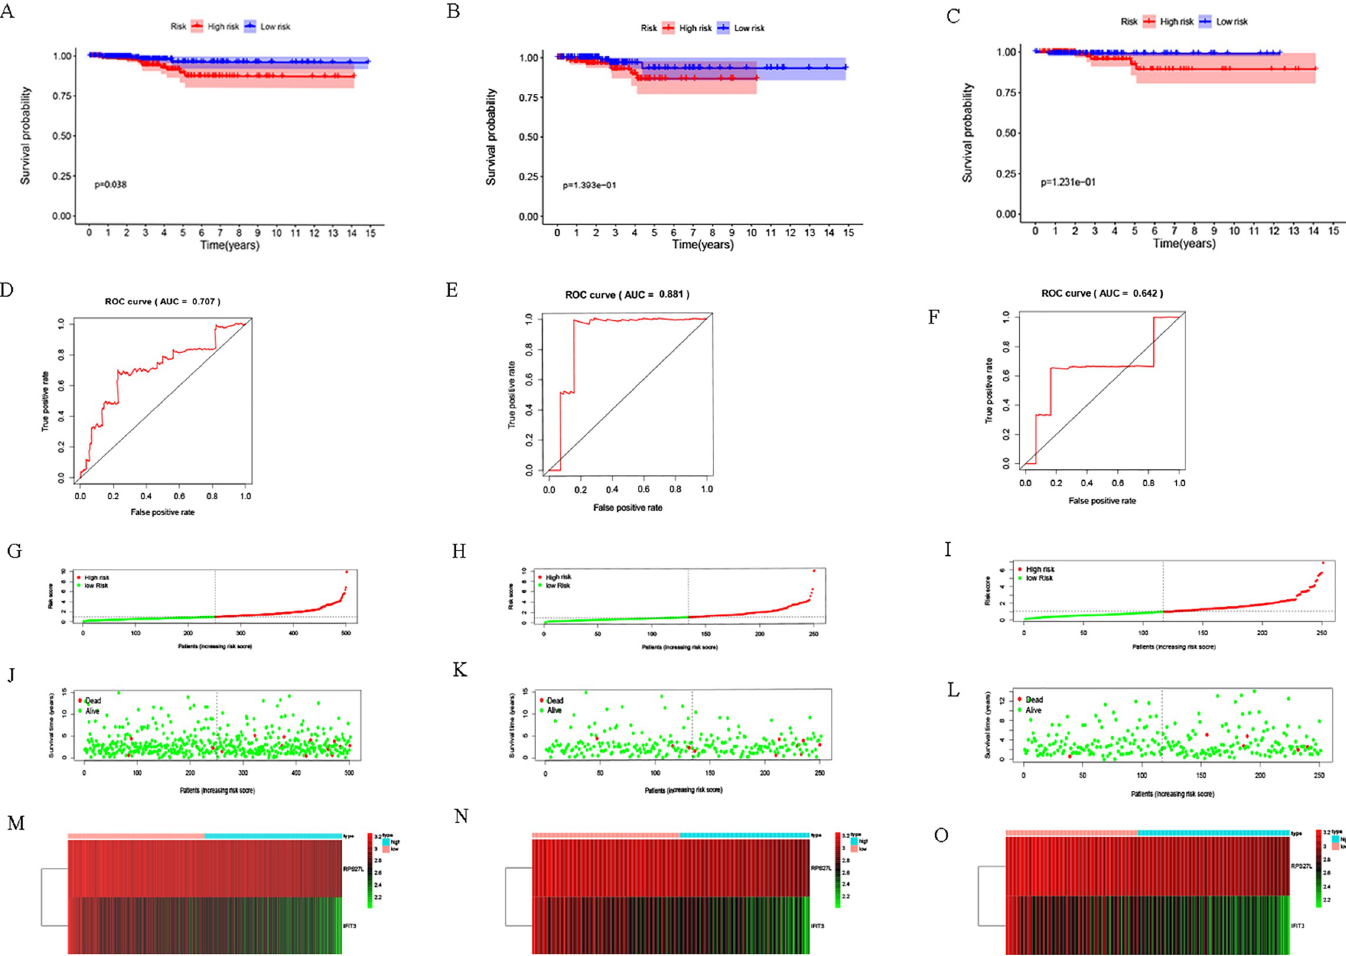
Fig 4. Risk score analysis of the prognostic model. (A) The Kaplan–Meier survival curves in the training set; (B-C) The Kaplan–Meier survival curves in two validation sets; (D) ROC analysis in the training set; (E-F) ROC analysis in the two validation sets; (G) Distribution of risk scores in the training set; (H-I) Distribution of risk scores in the validation sets; (J) Distribution of survival status of patients in different groups in the training set; (K-L) Distribution of survival status of patients in different groups in the two validation sets; (M) Heat map of 2 genes’ expression along with risk scores in the training set; (N-O) Heat map of 2 genes’ expression along with risk scores in the two validations